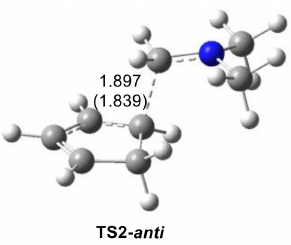
Figure 12. ω B97XD/6-311G(d,p) geometry of the stereoisomeric TS2- anti for the I-DA reaction of iminium cation 6 with Cp 1 . The distances are given in Angstroms. The gas phase distance is given in